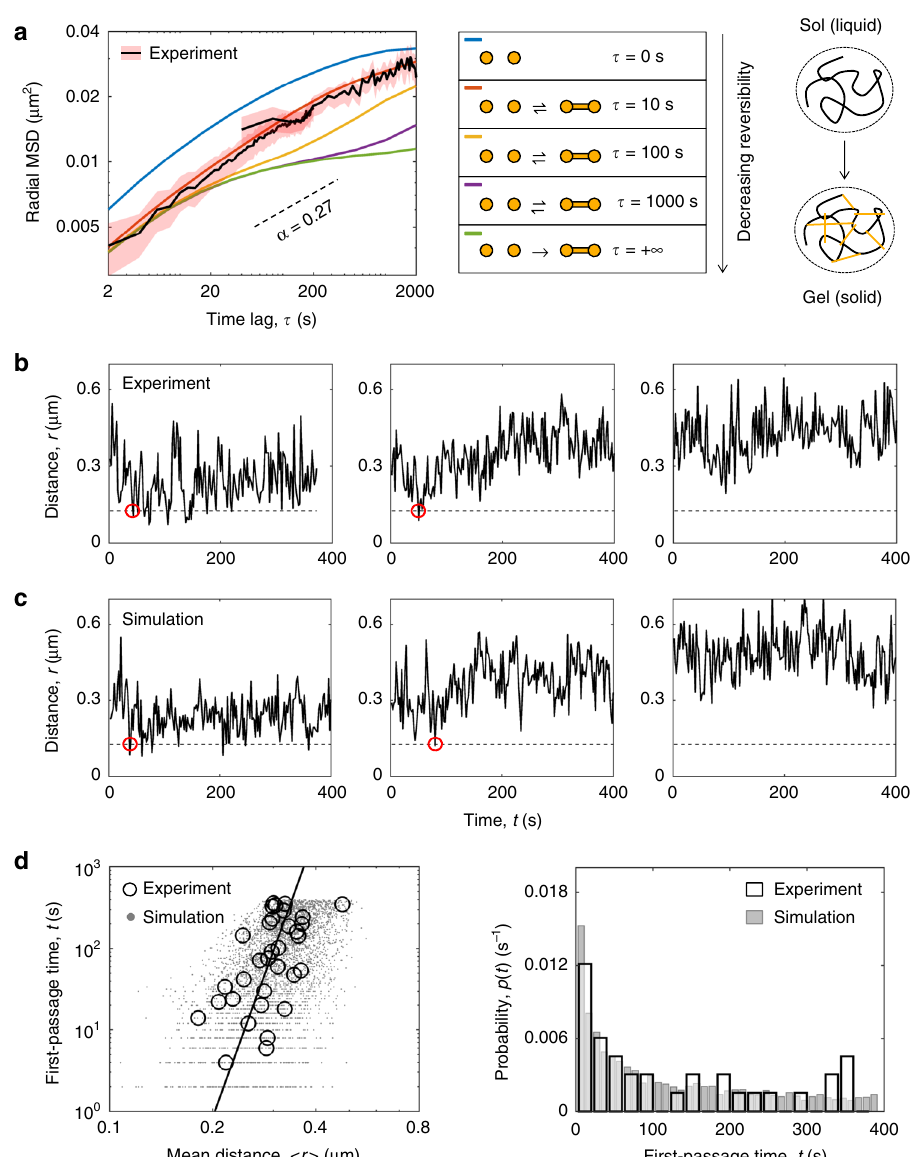
Fig. 5 A weak-gel model reproduces V H -D H J H fi rst-encounter times. a Tuning the lifetime of crosslinks results in a systematic change in the slope ( α ) of the MSD. Short-lived bonds (lifetime ~10 s) yield the best agreement between MSD derived from experiment and simulations. b Representative trajectories of the spatial distance within individual V H -D H J H pairs in STI-571 treated cells ( n = 121). Red circles indicate potential fi rst encounters. c Representative trajectories of V H -D H J H spatial distances generated from the MD simulations of the Igh locus when modeled as a weak gel. d First encounter times as a function of mean spatial separation from experimental and simulated V H -D H J H trajectories (left panel), and the corresponding probability distributions of experimentally derived and simulated fi rst-encounter times (right panel). Source data is provided as a Source Data V H -D H J H encounter times in a weak-gel state . The two-color imaging strategy enabled a direct estimation of the fi rst-passage times (FPTs), or the waiting times of the fi rst V H -D H J H